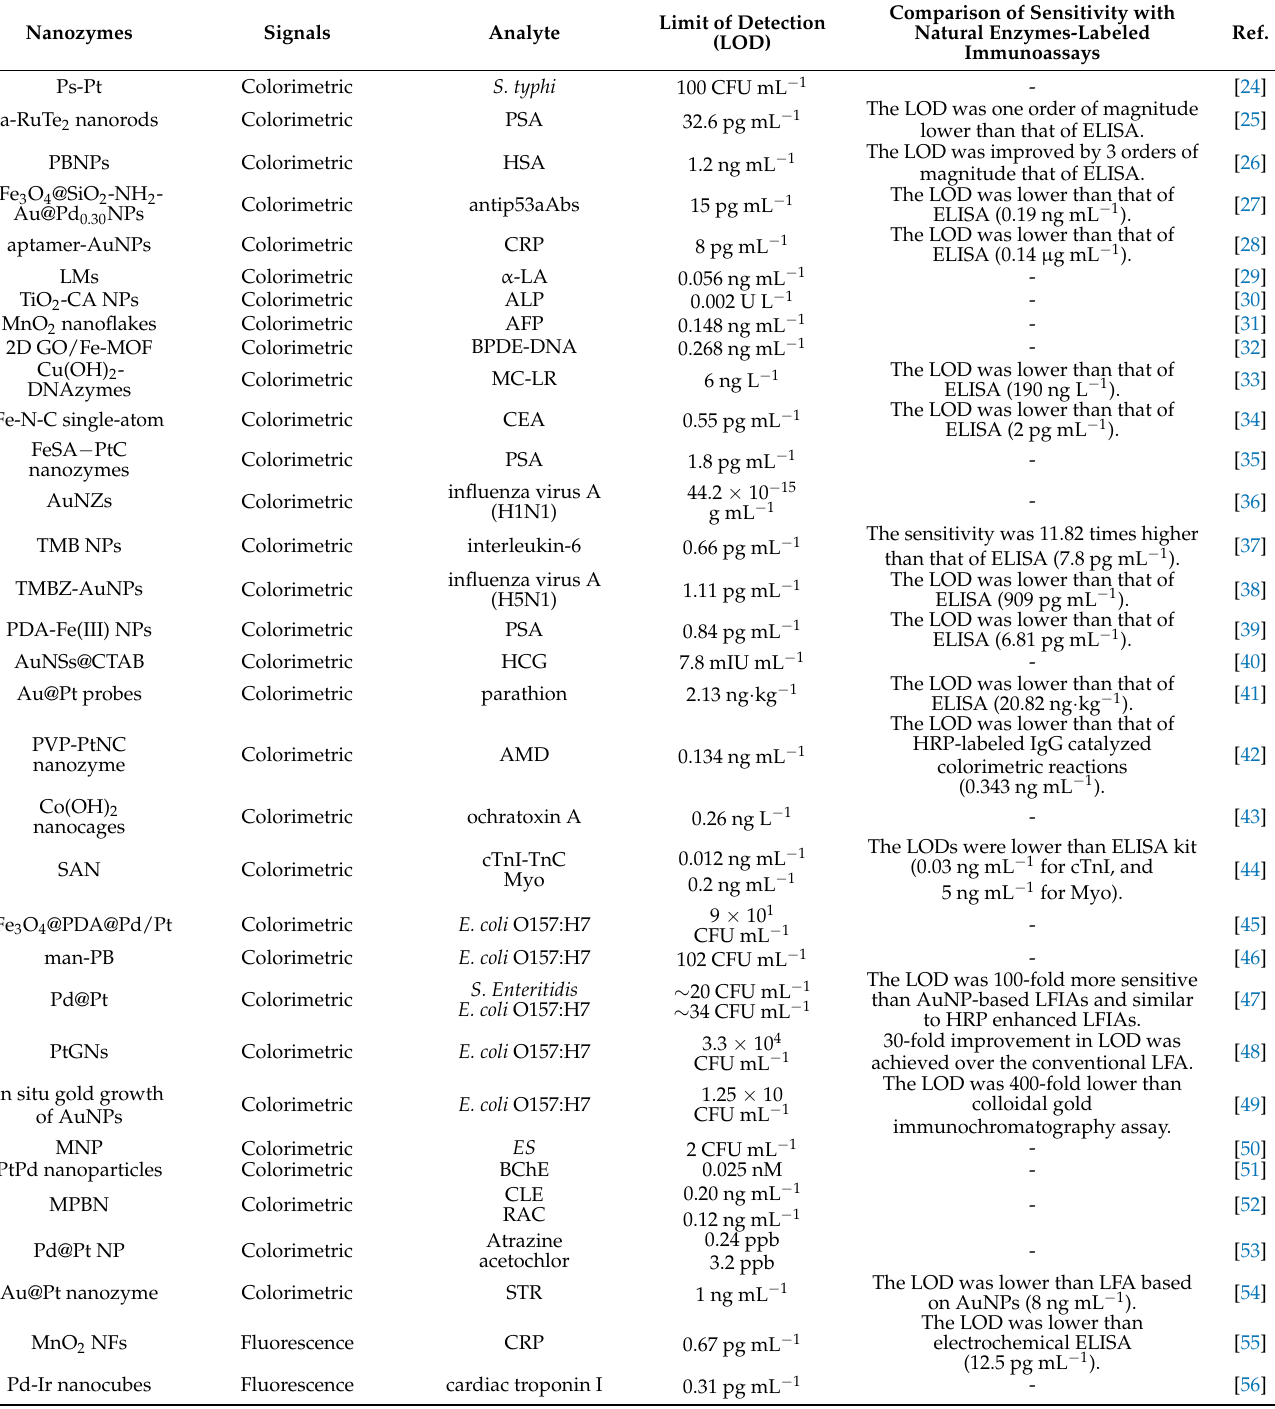
Table 1. Summarization of immunoassays with diverse signals based on nanozymes for target analytes